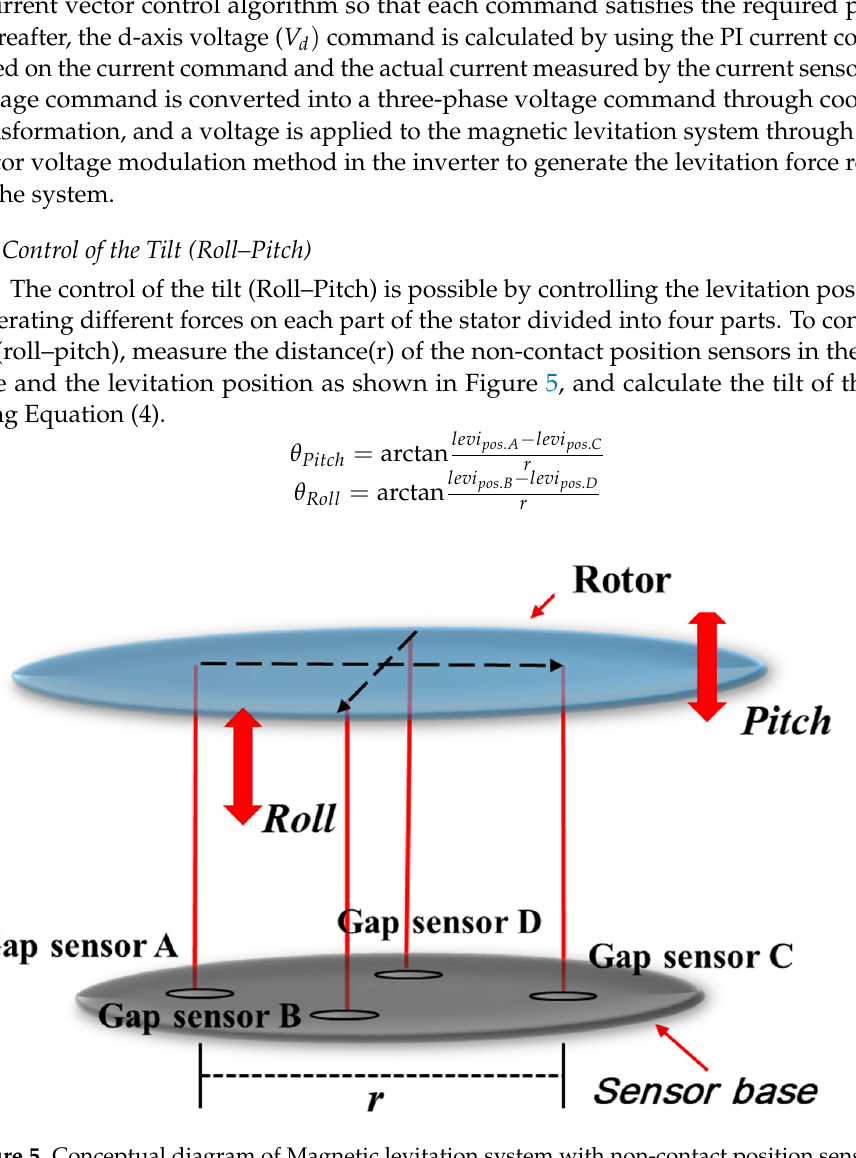
Figure 6. Control block diagram for the tilt (Roll–Pitch) (* is command value). 3.3. Method of Levitation and Tilt Sensing Using Gap Sensors Since the 6-DOF magnetic levitation system of this paper has no shaft and bearings, and when levitating, it can easily lose position information due to disturbance and force imbalance, leading to derailment and uncontrollable situations. Therefore, stable levita- tion control of the magnetic levitation system and control to maintain a balance of forces are absolutely necessary. In the case of magnetic levitation using repulsive force, the re- pulsive force decreases as the gap between the stator and the rotor increases. Therefore, as shown in Figure 7, the limits and commands of levitation, roll and pitch control should be calculated using the main sensing range of the gap sensor. Considering the Z-axis sens- ing range of the sensor in Figure 7, each control command and limit for the control of levitation and tilt (Roll Pitch) was set as shown in Figure 8, and through this, magnetic levitation and tilt control were performed.